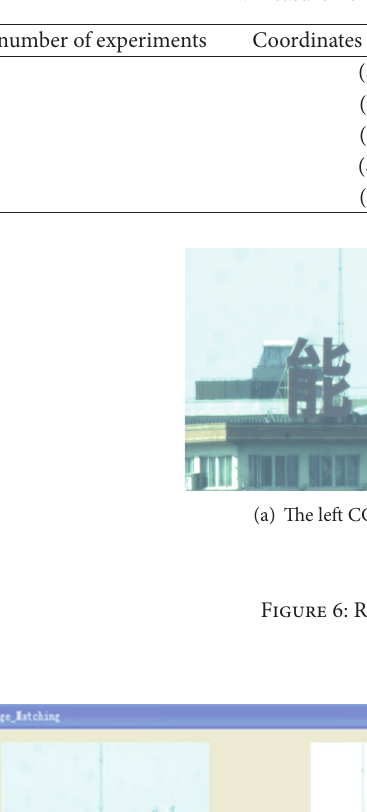
Table 1: Measurement data of ranging image groups for “Energy Bureau of Jilin Province.”